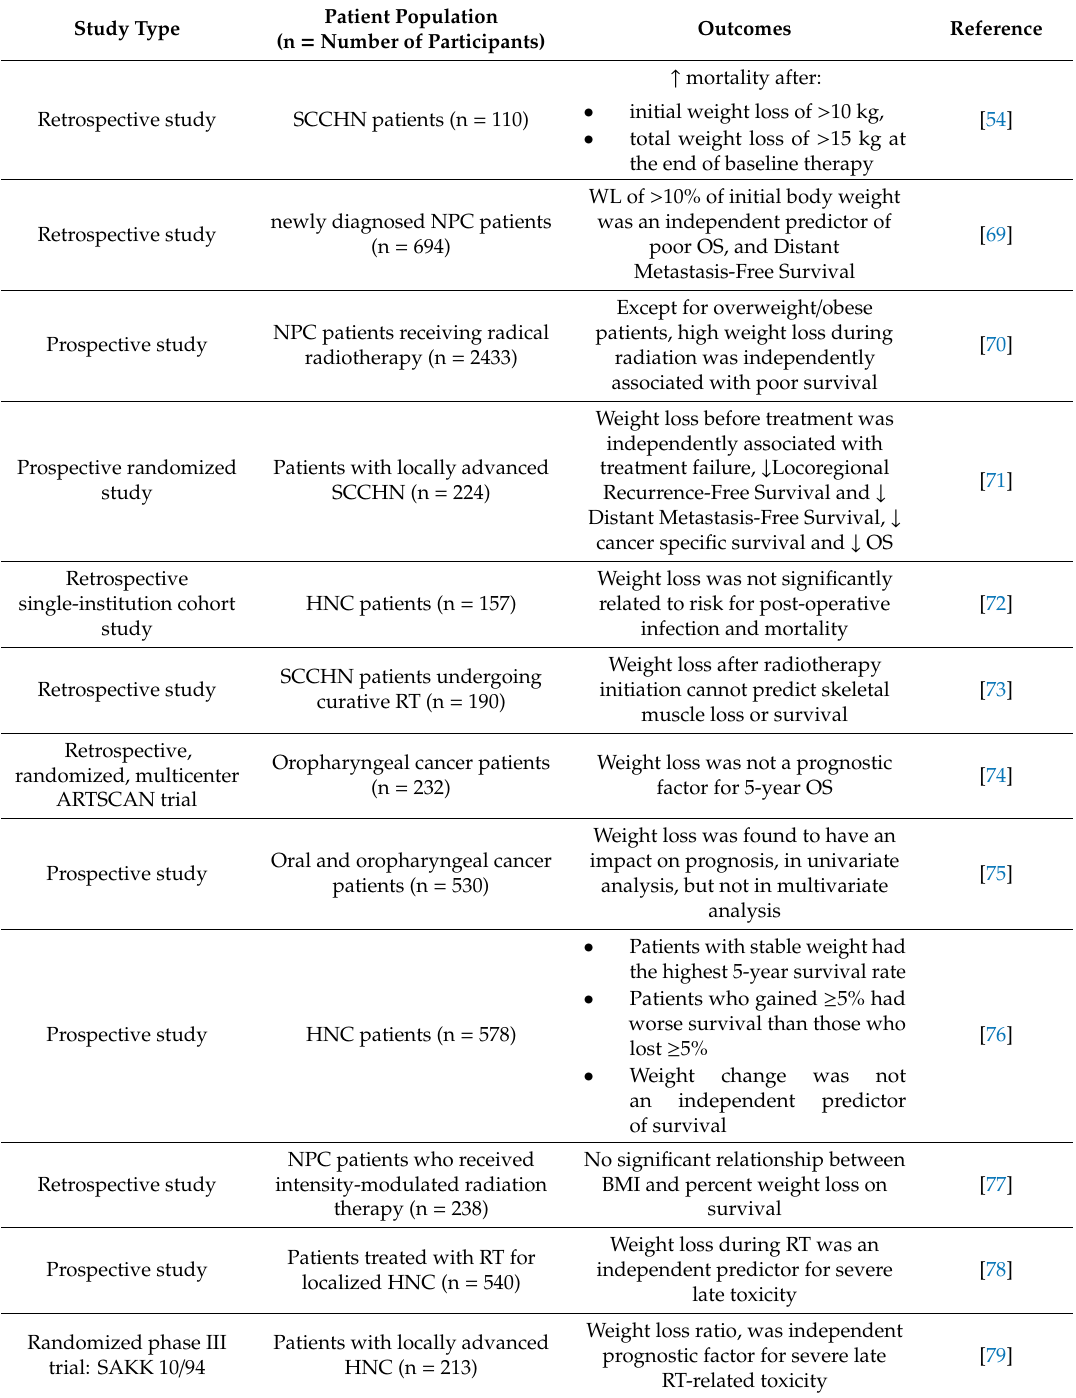
Table 5. Studies examining the prognostic role of weight loss on survival and / or treatment